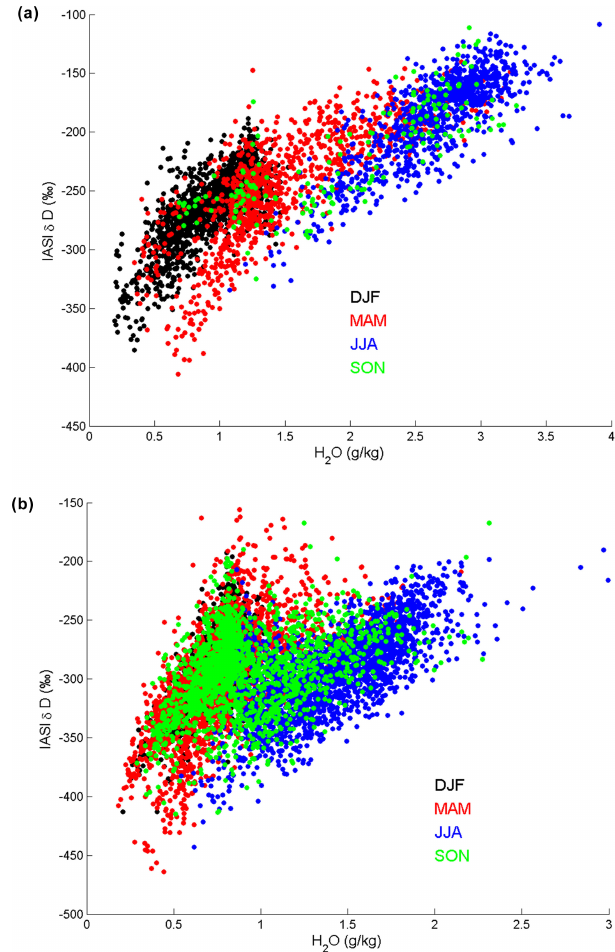
Figure 12. IASI δ D as a function of H 2 O (gkg − 1 ) for the four seasons between 0 and 3km when | 1T | > 8K (a) and between 1 and 5km when | 1T | < 4K (b)